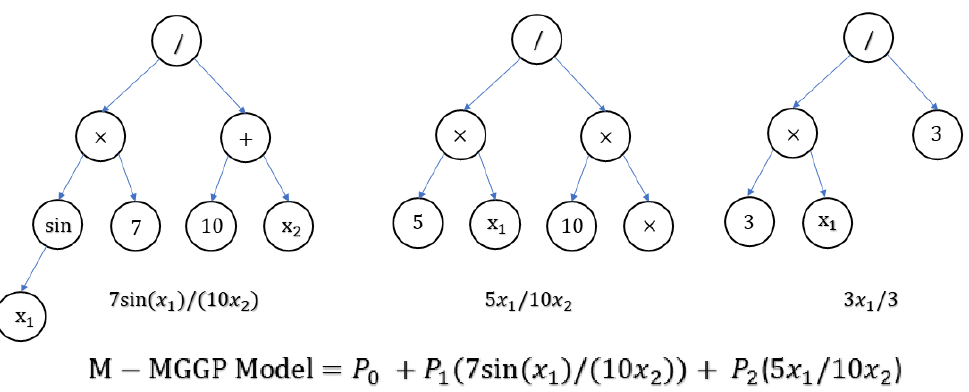
Figure 8. M-MGGP formulation using stepwise regression approach.